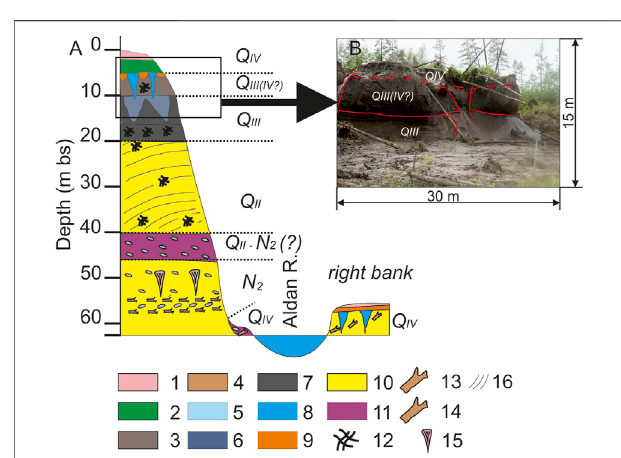
FIGURE2| MamontovaGoraoutcrop: (A) Geologicalsectionacrossthe Aldan River in the area of the V terrace of the Mamontova Gora outcrop. (B) thermocirque, exposing two generations of thick ice wedges (photo by D.G. Shmelev). Legend: 1) active layer, 2) icy darkgray loams — cover layer, 3) icy dark gray, black loams with organic matter and thick-schlieren cryostructure, 4) thawed clays and silts; 5) wedge ice, milky white, 6) wedge ice, muddy, 7) loam with massive cryostructure, gray and dark gray, 8) water (here its the Aldan R and it is Syrdakh lake for Figure 3 ), 9) peat, 10) sands medium to coarse-grained, 11) gravel-pebble deposits with sandy interlayers, 12) organic inclusions (plant remains), 13) wood remains, 14) pebbles and boulders, 15) pseudomorphs, 16) lithological